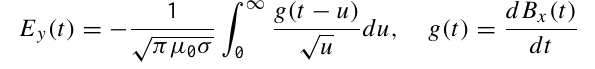
Fig. 1. Oil pipelines in the Czech Republic, the measuring stations used in the present analysis and the Reference Geomagnetic Obser- vatory Budkov.